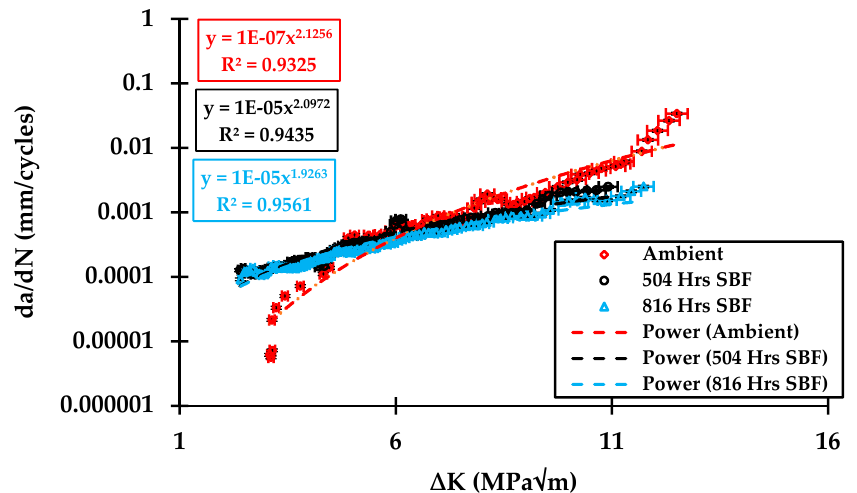
Figure 6. da / dN vs. ∆ K results for the ambient, 504-, and 816-hr samples in simulated body fluid (SBF). Power in Figure shows that the curve fit has been achieved using the power law